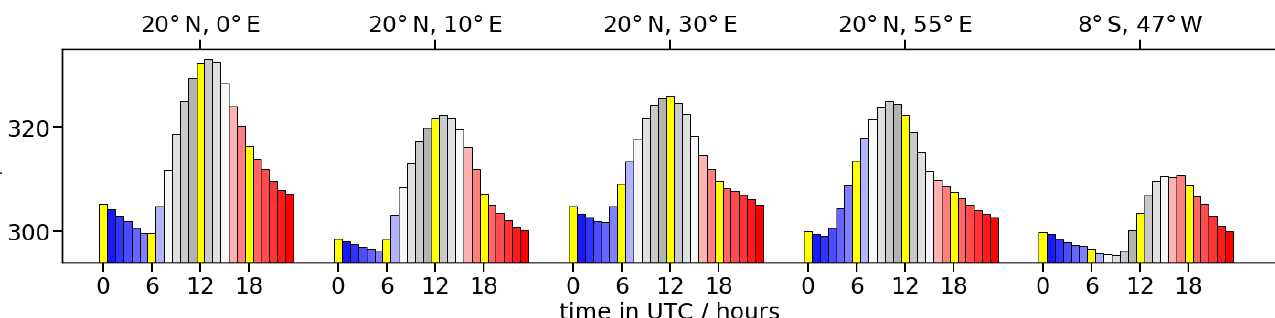
Figure 3. Differences in the skin temperature (from ECMWF ERA5): between the maxima and minima of the daily means of the 15th of each month in 2010, i.e., the annual variability ( a ); between the maxima and the minima of the 15 May 2010, i.e., the daily variability ( b ); between the daily means of 15 May 2010 and 2015 at 12:00 UTC, i.e., the inter-annual variability ( c ). The blue dots mark the locations shown in Figure 4.